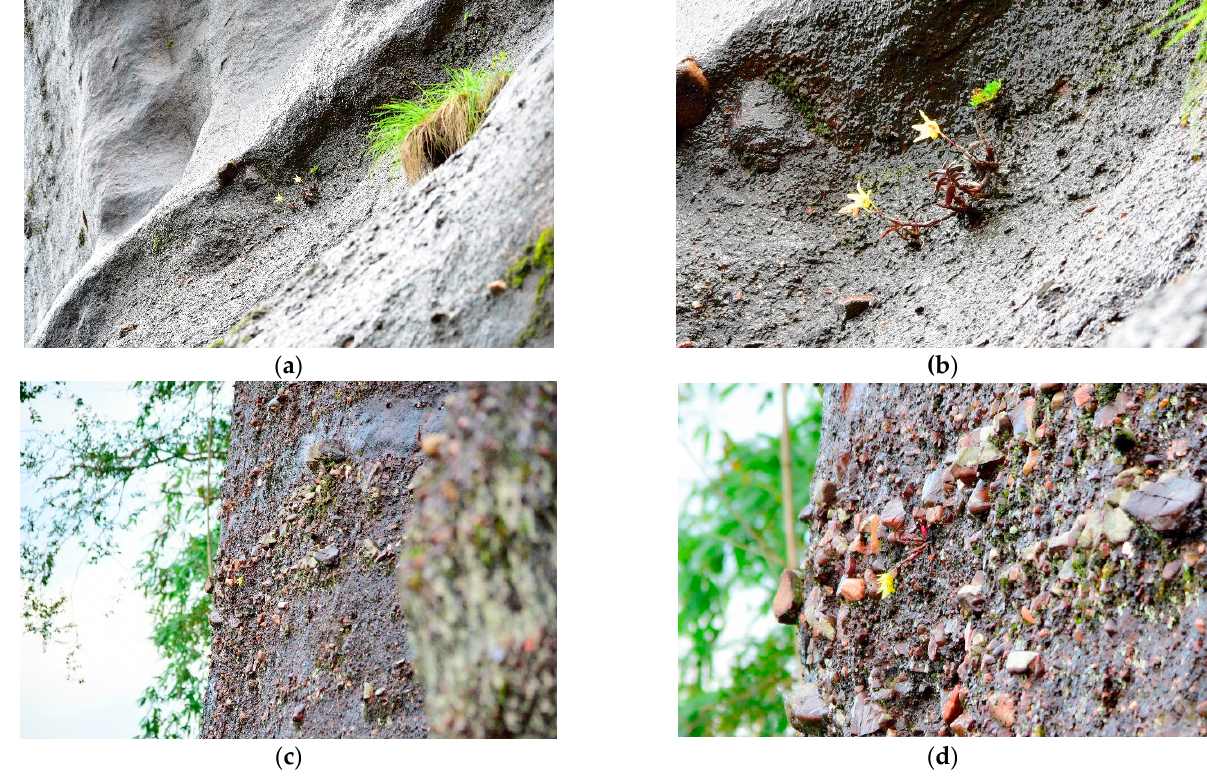
Figure 1. The ecological environment of wild D. officinale . Some of the wild D. officinale grows on the cliffs at an altitude of 274.5 m, and the geographic location is 25°1’27’’ N, 113°1 ′ 44 ″ 2 E. ( a ) Two clusters of wild D. officinale growing on a stone wall in the distance. ( b ) Close up view of two clusters of wild D. officinale growing on the stone wall. ( c ) One cluster of wild D. officinale growing on a stone wall in the distance. ( d ) Close up view of a cluster of wild D. officinale growing on a stone wall. The researchers did not cause damage to wild D. officinale by long-distance shooting.